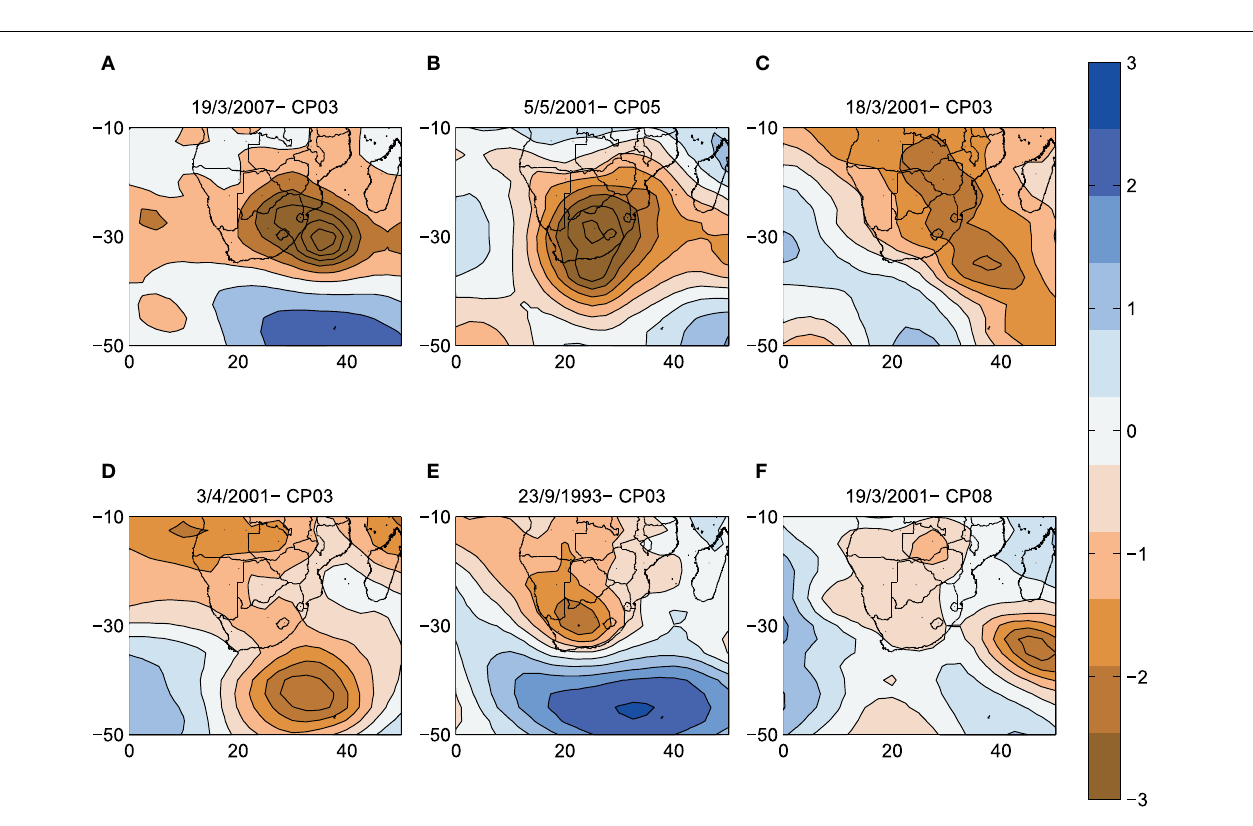
region are more similar than classifications corresponding to different regions. This justifies the use of different classifications for the different regions and variables, because they add discriminatory power to the modeling